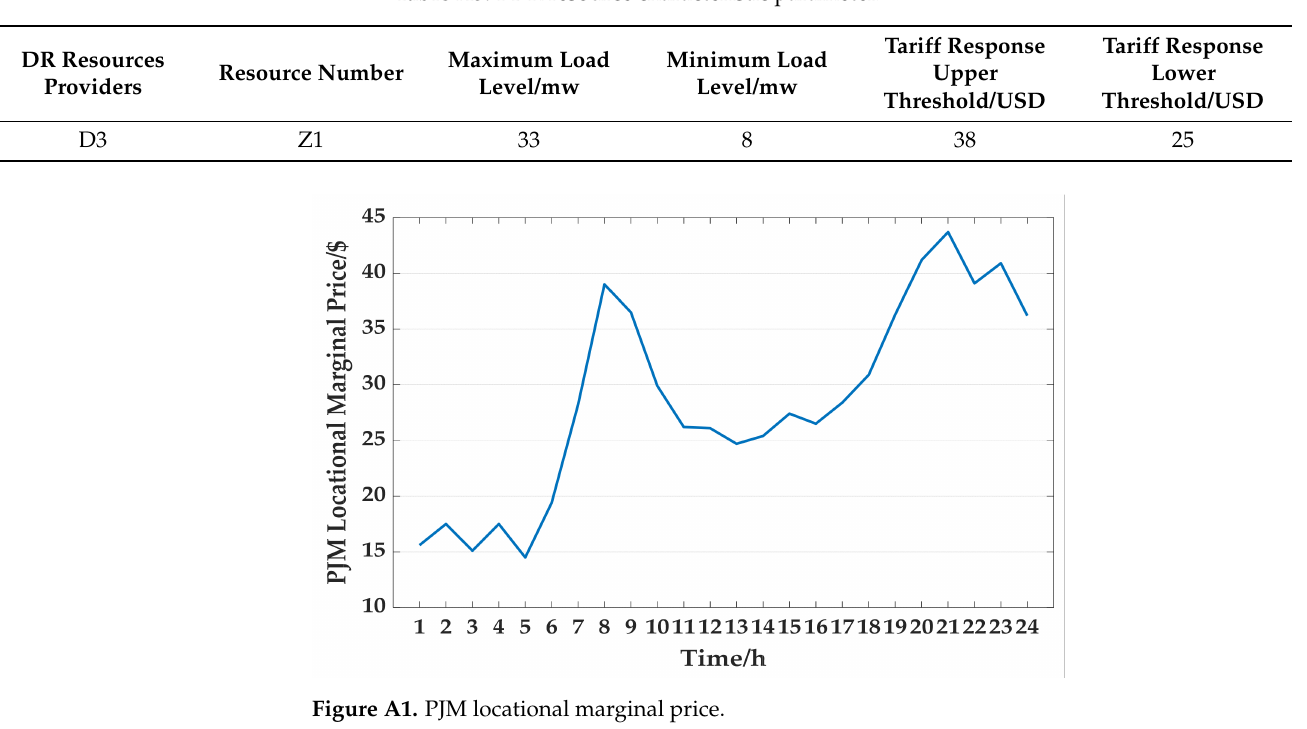
Figure A1. PJM locational marginal price.